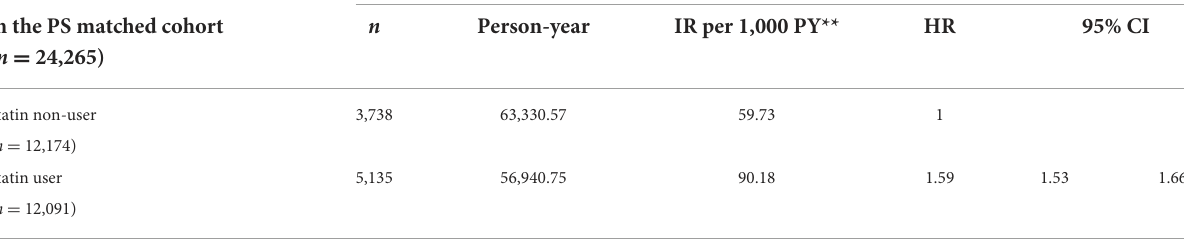
TABLE 6 Hazard ratio of new-onset DM by statin